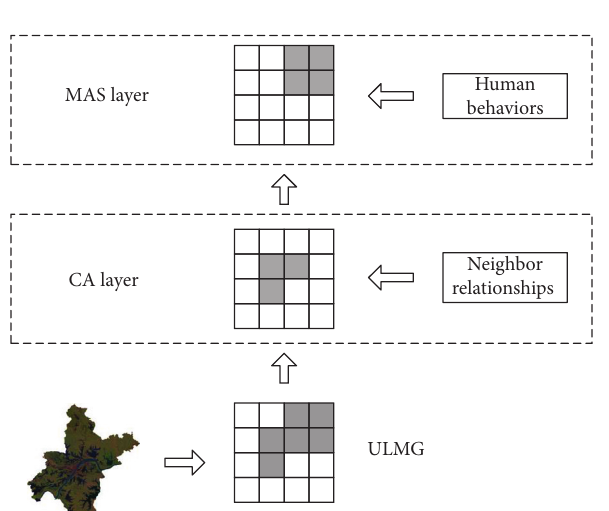
Figure 5: A case of ULMG for Wuhan.